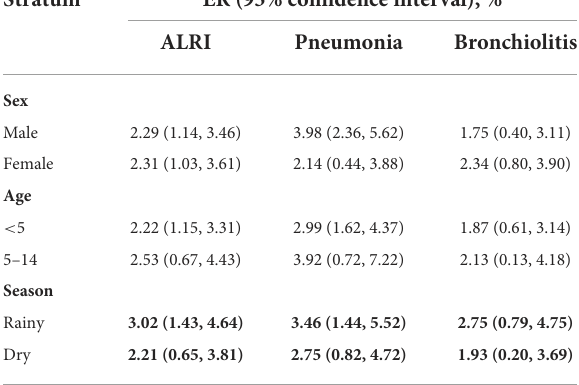
TABLE 2 Excess risk and 95% confidence intervals of ALRI, pneumonia, and bronchiolitis for each 1 ◦ C increments in DTR stratified by gender, age group, and